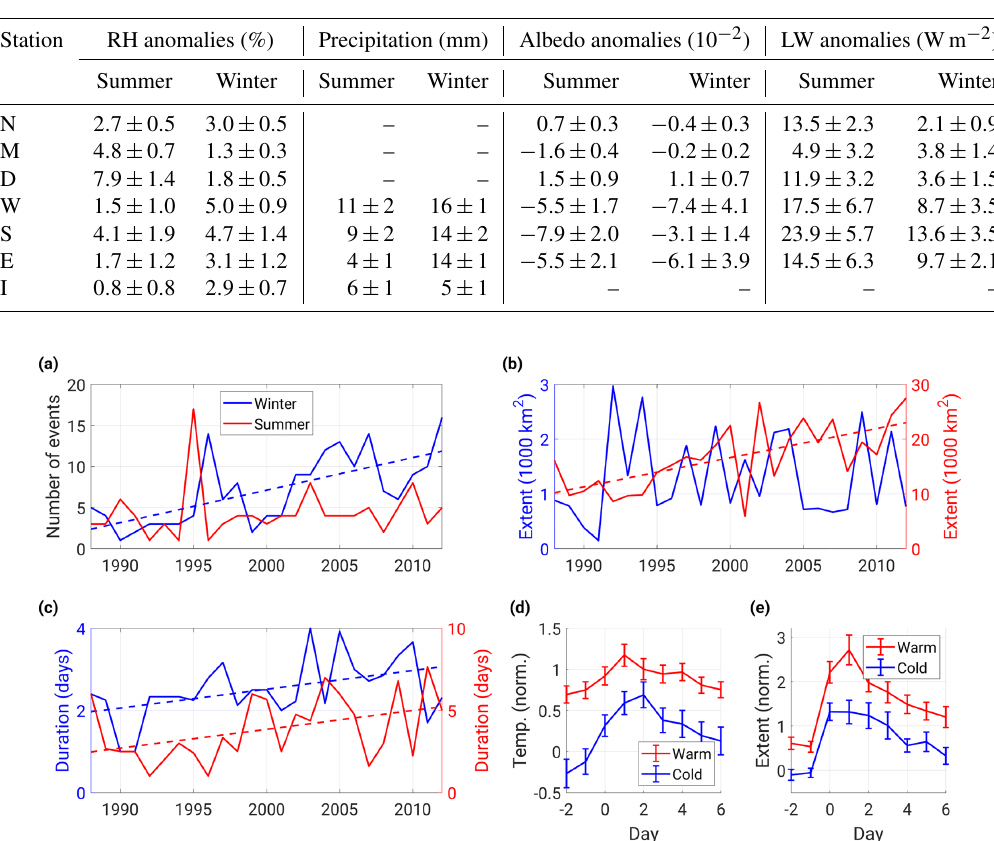
Table 1. Precipitation (totals) and the relative humidity (RH), albedo and longwave (LW) radiation anomalies (positive downward) during melt events in summer and winter, obtained from weather stations (Fig. 2c). Precipitation is summed over the days 0 to 2 of the events (days 1 to 3 for Station East because there is a ∼ 1 day delay of the warming). If precipitation occurs as snow, it is melted before the measurement. Relative humidity and longwave radiation are averaged from day 0 to 2 and the albedo from day 1 to 3 (again one day later for Station East). All anomalies are with respect to the week before the events. Uncertainties represent the standard error of the mean.